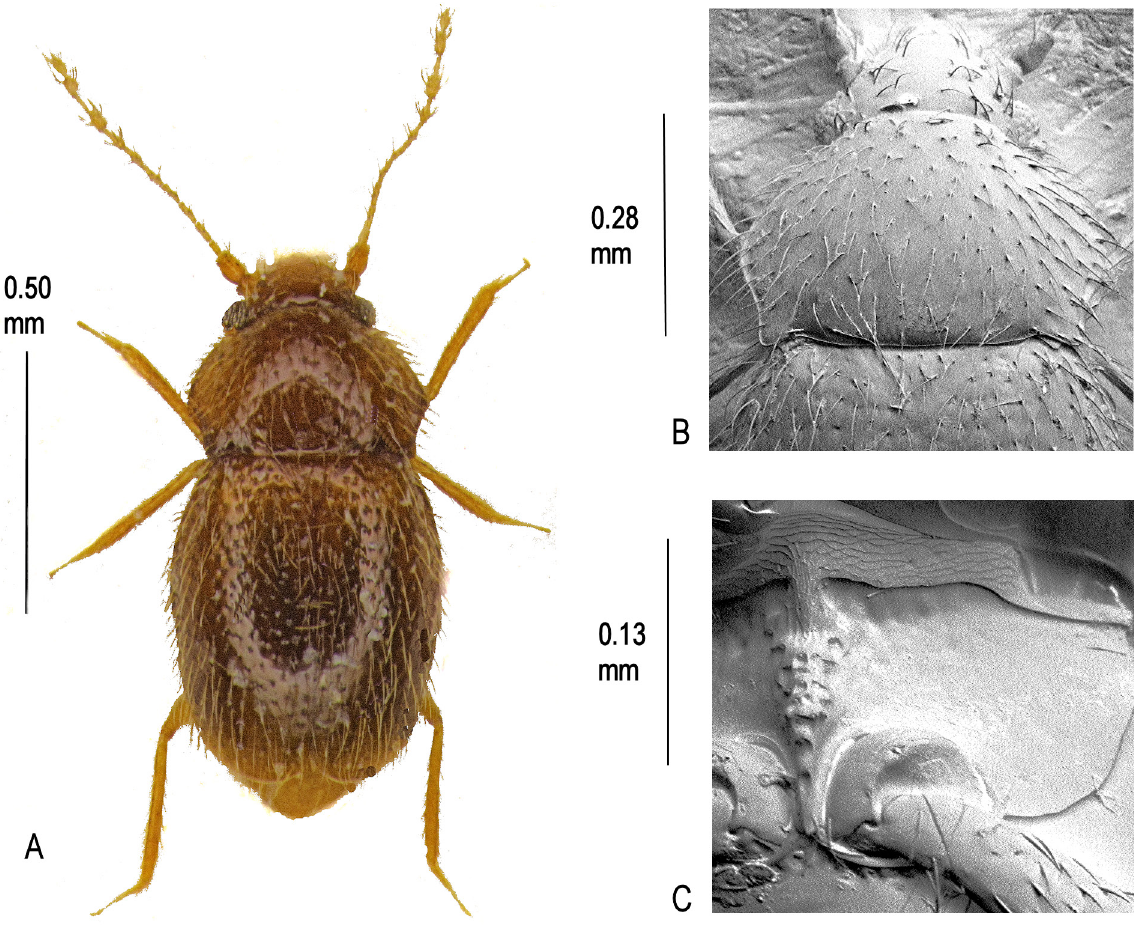
Fig. 95 . Cissidium losbanos sp. nov. A . Habitus. B . Pronotum, × 350. C . Mesoventrite showing median process of collar, mid-keel and keel,